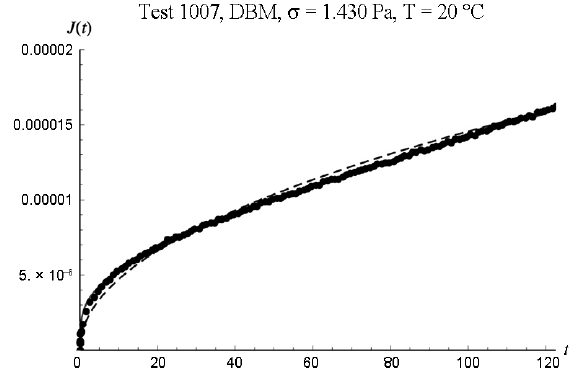
Fig. 5. DBM Experimental data (dots) contrasted with best- fitting curves of the proposed model (continuous line) and the Scott-Blair model (dashed line), 20